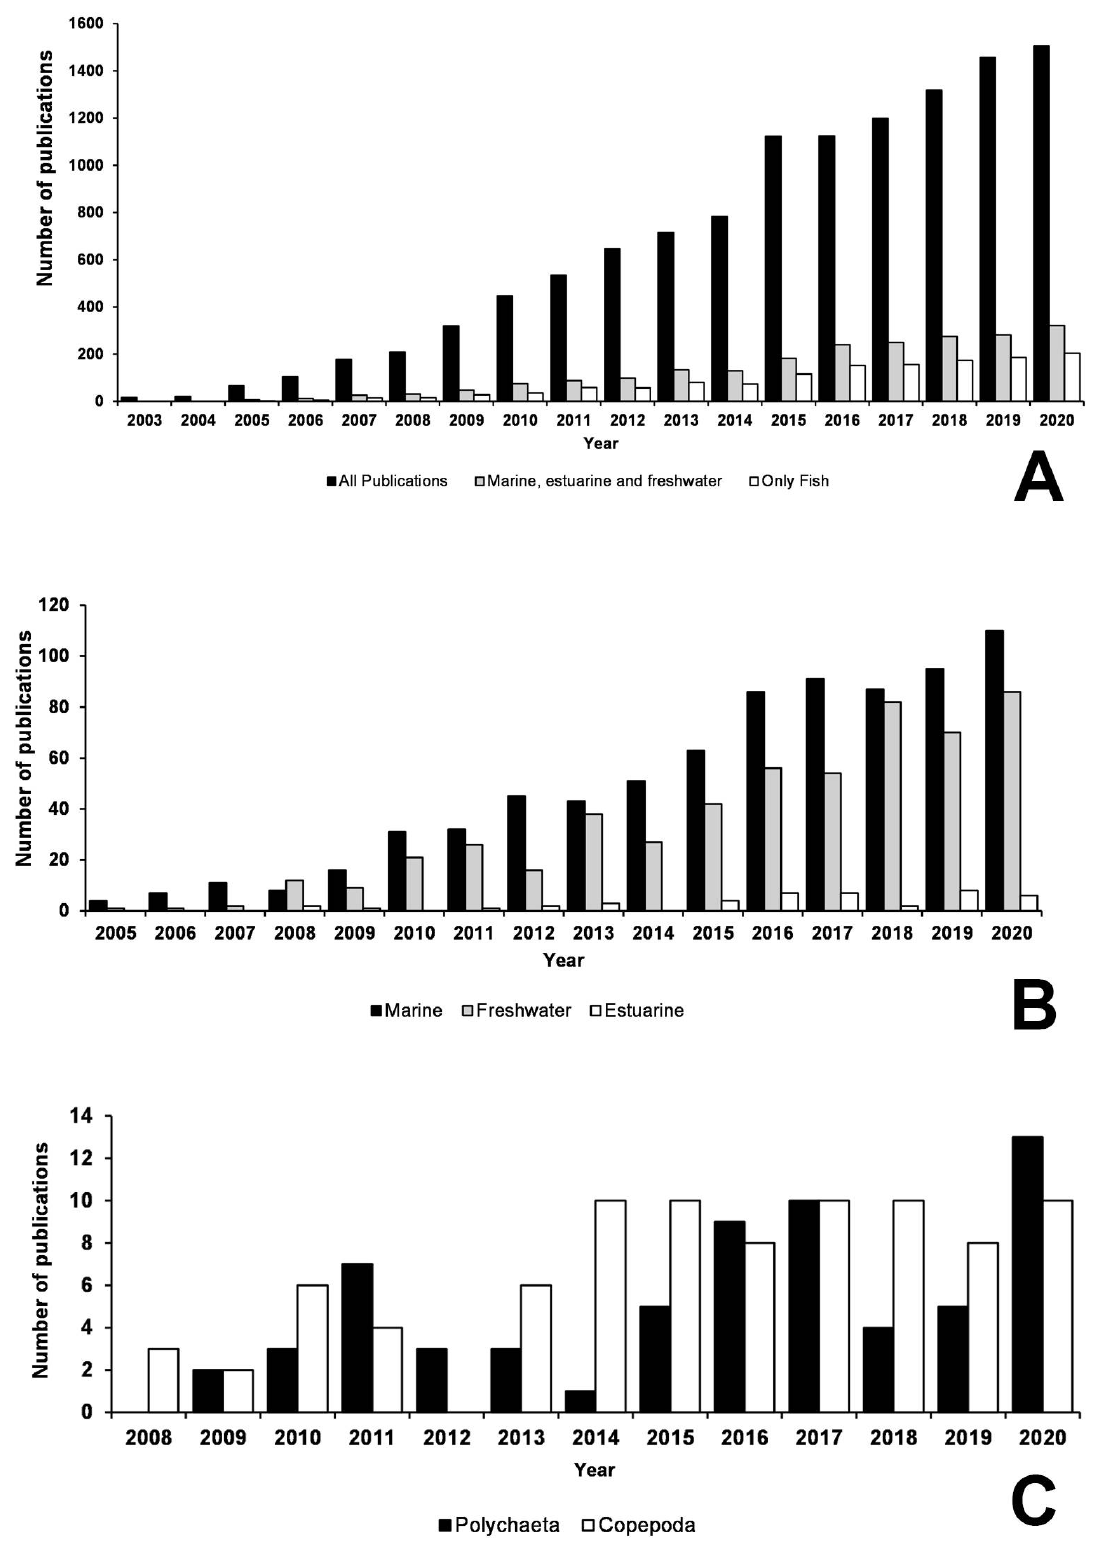
Figure 1. Studies on DNA barcoding on aquatic life. ( A ) Total studies, including all types of aquatic environments and fishes; ( B ) Studies in three different aquatic environments; ( C ) Studies with focus on two of the major groups of aquatic